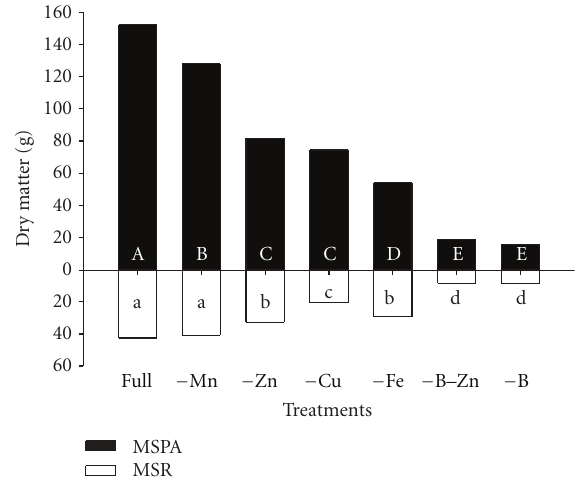
Figure 2: Total dry matter yield (g) of the Australian Red Cedar plants after 90 days in pot with a nutrient solution. Data followed by equal letters do not di ff er from one another by the Scott Knott test at 5% of probability. Statistical analyses for means at 90